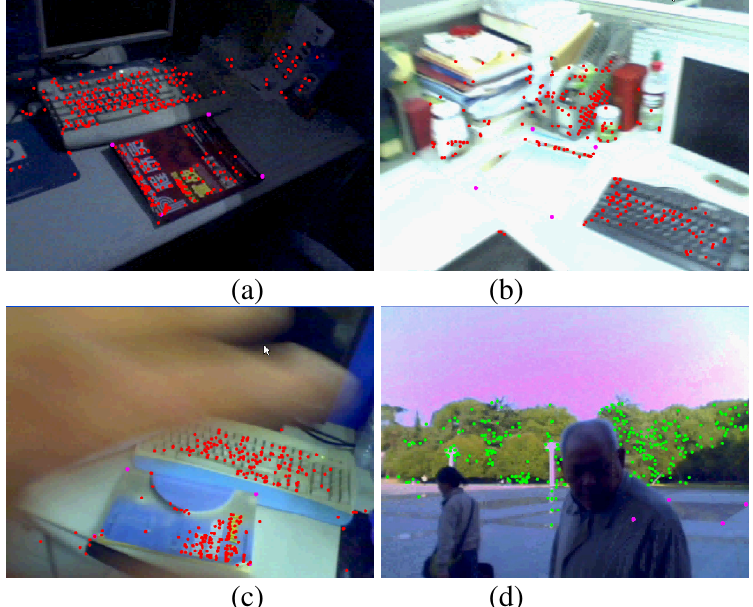
Figure 7. Relocalisation results with occlusions and illumination changes.